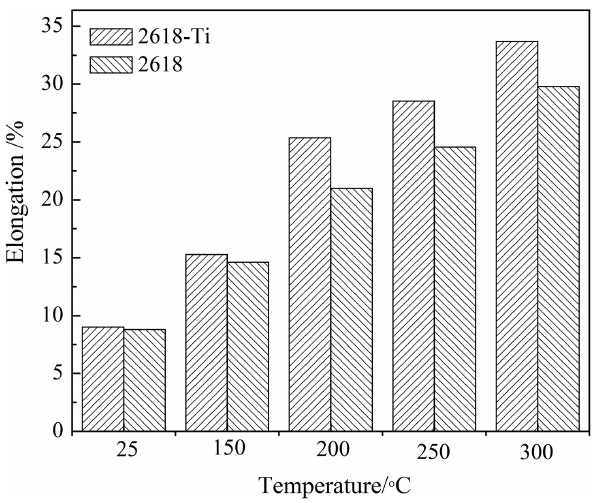
Figure 3: The elongation of alloy 2168 and 2618-Ti at different